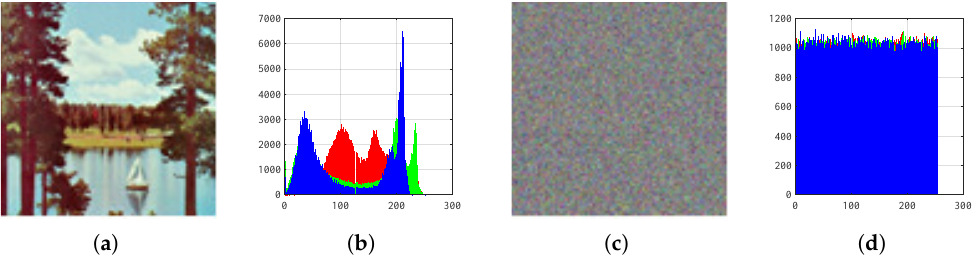
Figure 15. Histograms: ( a ) Sailboat image, ( b ) histogram of plain Sailboat, ( c ) encrypted Sailboat, and ( d ) histogram of encrypted Sailboat.